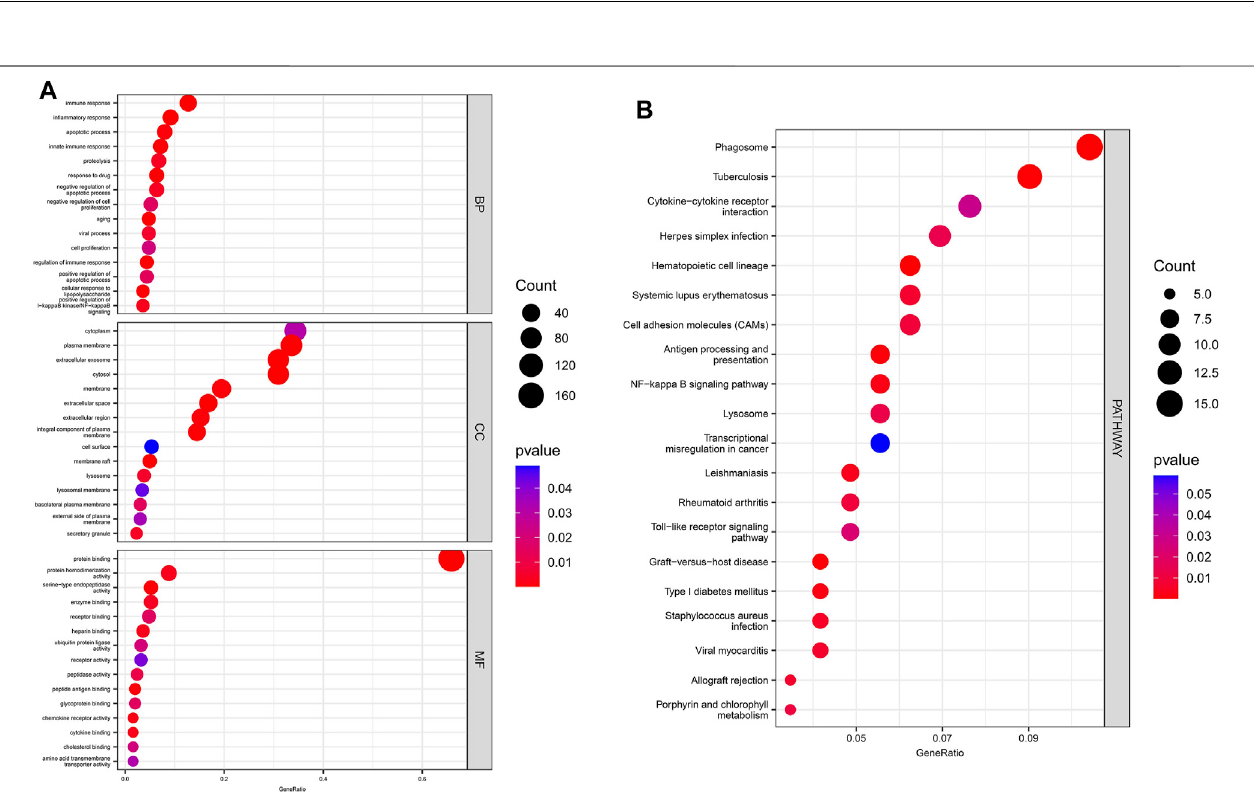
FIGURE4| GO/KEGGenrichmentanalysisforDEmRNAs. (A) Thetop15enrichedGOtermsforDEmRNAs. (B) Thetop20enriched termsinKEGGpathwaysfor DEmRNAs.